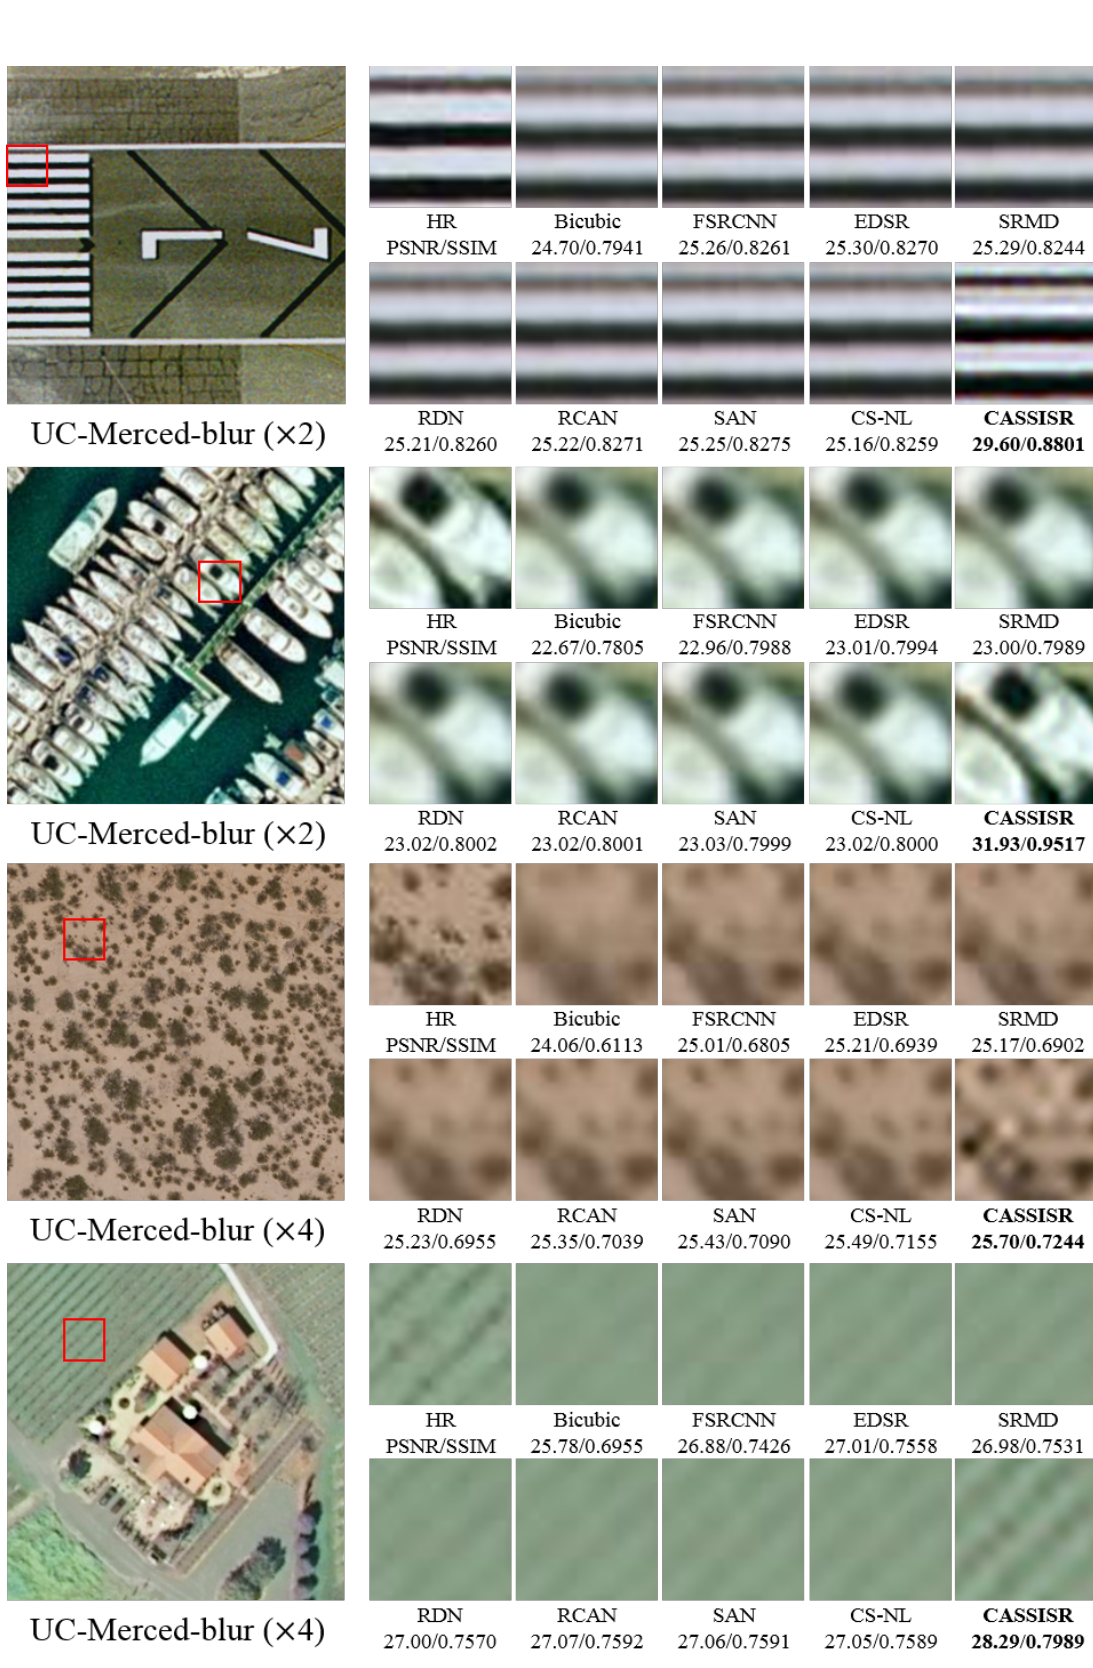
Figure 7. Qualitative comparison of scaling factors × 2 and × 4 between CASSISR and CNN-based SR methods on UC- Merced-blur dataset. Our CASSISR results are highlighted